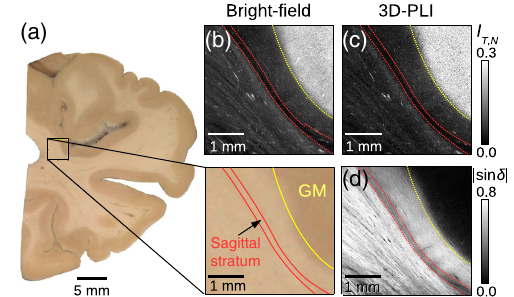
FIG. 12. Bright-field transmission microscopy vs 3D-PLI measurement of a human brain section (right occipital lobe). (a) Photograph of the brain block surface before sectioning (blockface image). The enlarged region shows the sagittal stratum, a white matter structure that runs mostly perpendicular to the section plane (GM ¼ gray matter). (b) Bright-field transmission microscopy image of the same region with 0 . 91 μ m pixel size. (c) Normalized transmittance image of the same region obtained from a 3D-PLI measurement with 1 . 33 μ m pixel size. (d) Correspond- ing retardation image. Regions with steep out-of-plane fibers (sagittal stratum) show lower transmittance (and retardation) values than the neighboring regions with nonsteep fibers; the transmitted light intensity images obtained from bright-field transmission microscopy (b) and 3D-PLI (c) look